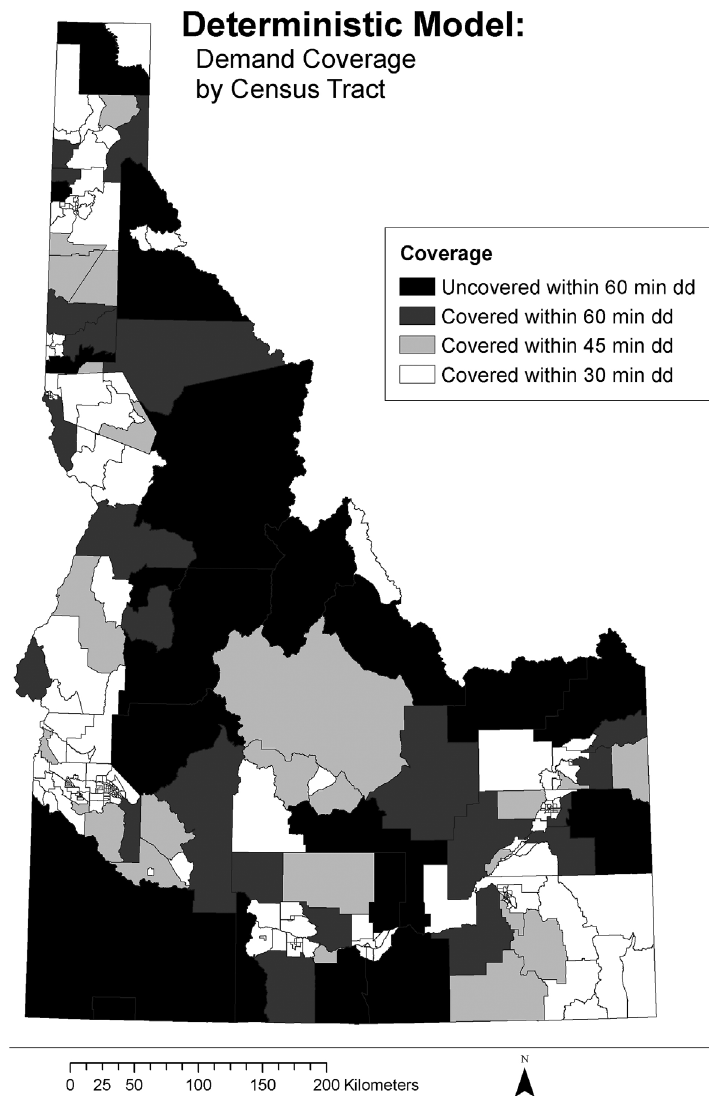
Fig. 3. Tract model coverage (dd = driving